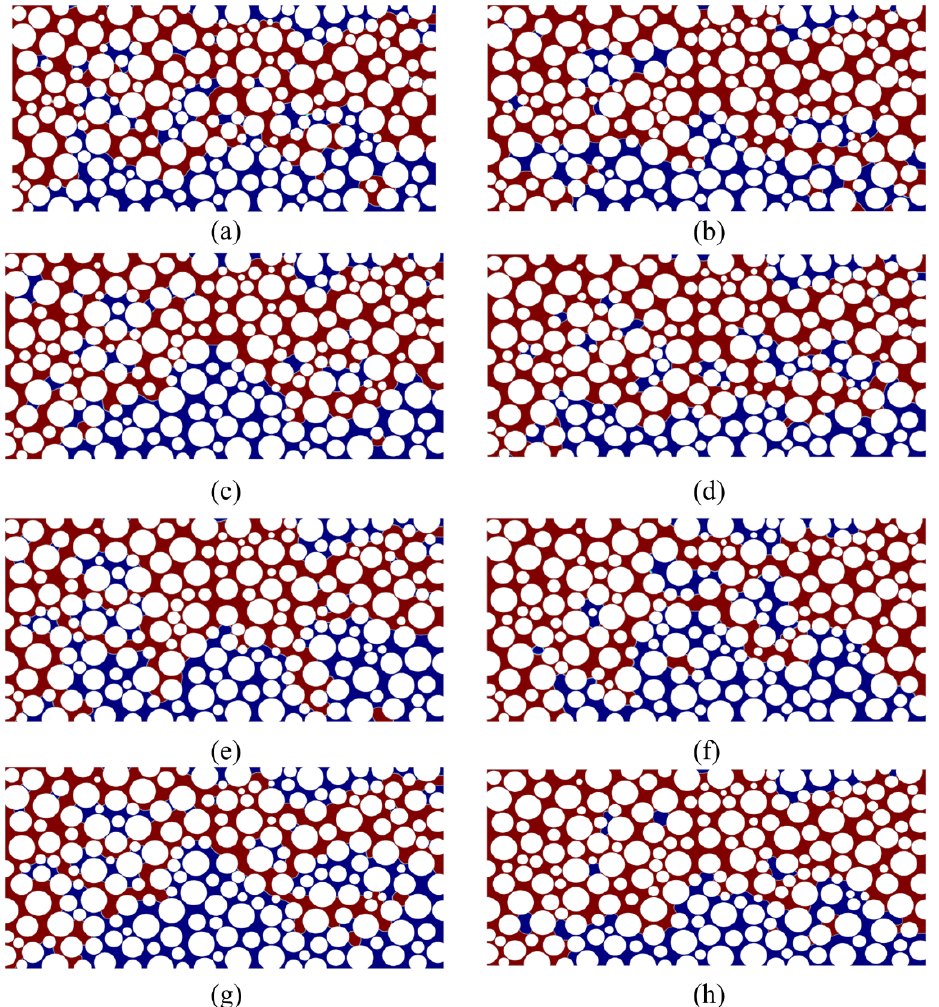
Figure 21. CO 2 saturation distribution corresponding to 3 PV number of CO 2 injected under mixed wettability conditions. ( a ) Oil-wetted particles account for 70%; ( b ) Nonoil-wetted particles account for 70%; ( c ) Large particles, oil-wetted, account for 47.62%; ( d ) Large particles, nonoil-wetted, account for 47.62%; ( e ) Oil-wetted area accounts for 66.67%; ( f ) Nonoil-wetted area accounts for 66.67%; ( g ) Oil-wetted particles account for 100%; ( h ) Nonoil-wetted particles account for 100%; red and blue regions represent CO 2 and oil, respectively.